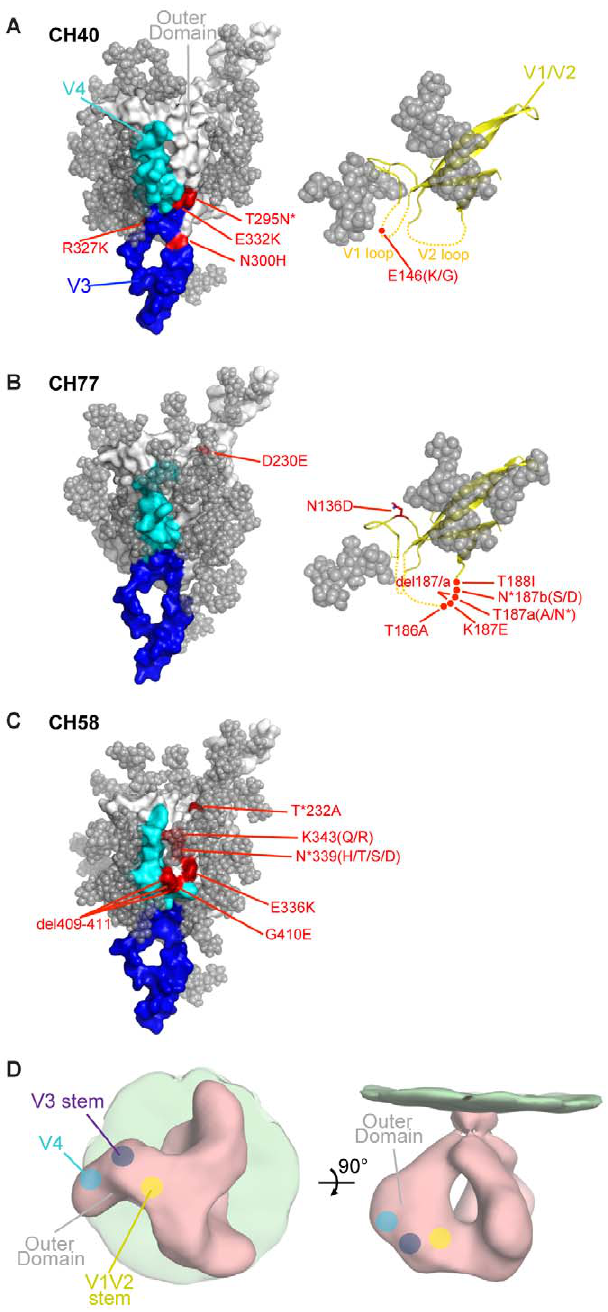
Figure 6. Env models. Models of gp120 molecules from (A) CH40, (B) CH77, and (C) CH58 are shown as white surface projections, with the V3 and V4 loop regions colored in blue and cyan. Models of the V1/V2 regions of CH40 and CH77 are shown as yellow ribbons with parts of the variable V1 and V2 loops shown as dotted lines. Potential N-linked glycans are modeled as grey spheres. Nab escape mutations are shown in red (HXB2 numbering), with mutations removing or adding a potential N-linked glycosylation site marked with an asterisk. (D) Schematic of putative V1/V2 (yellow dot), V3 (blue dot), and V4 (cyan dot) locations on the Env trimer.